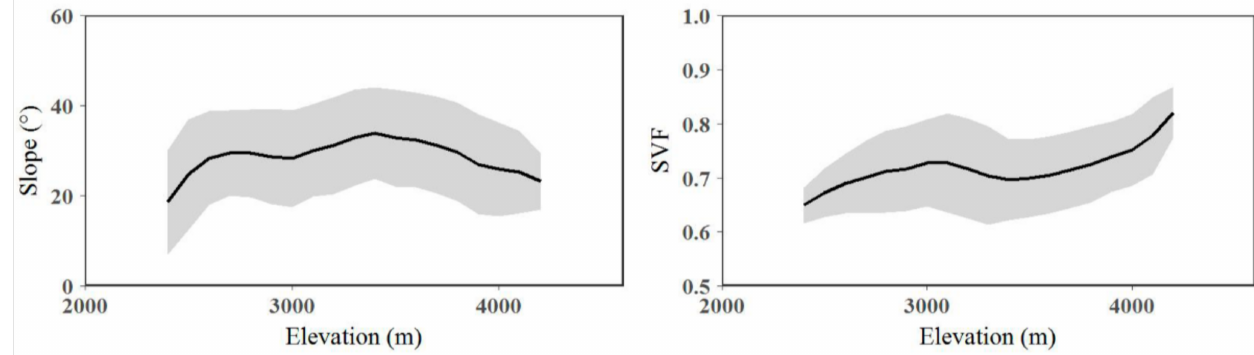
Figure 8. Relationships between elevation and slope and SVF over Wanglang Reserve. The solid line and ribbon represent the mean and standard deviation values in each elevation range (calculated at the interval of 100 m), which was obtained from the DEM, slope, and SVF maps at the 30 m